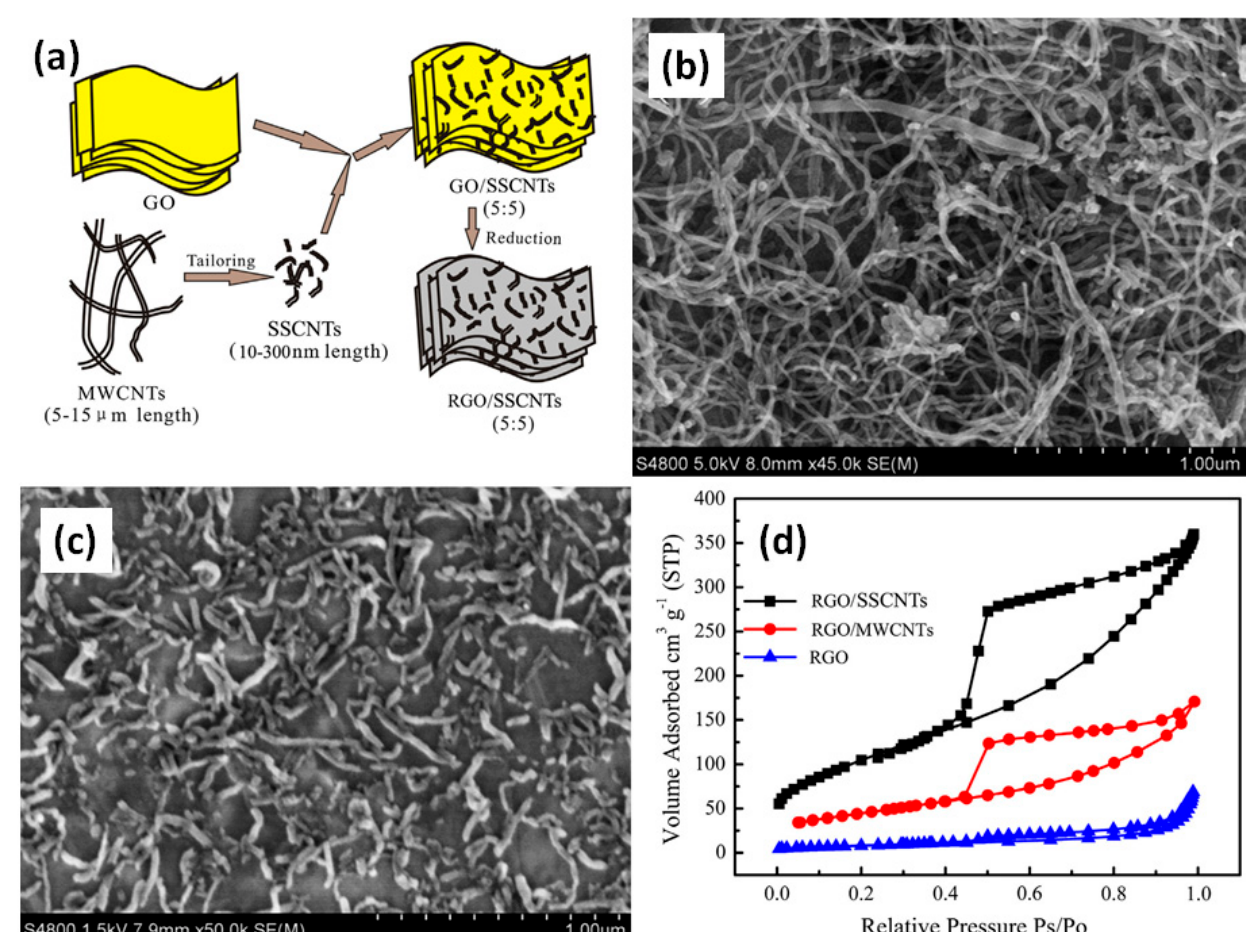
Figure 7. Schematic illustration of the formation steps of the multilayer rGO/super short CNT (SSCNT) architecture ( a ). Scanning electron microscope (SEM) images of raw multiwall CNT (MWCNT) ( b ) and SSCNT ( c ). Nitrogen sorption isotherms obtained at 77 K ( d ) (Reproduced with permission of [22]. Copyright Elsevier, 2013).